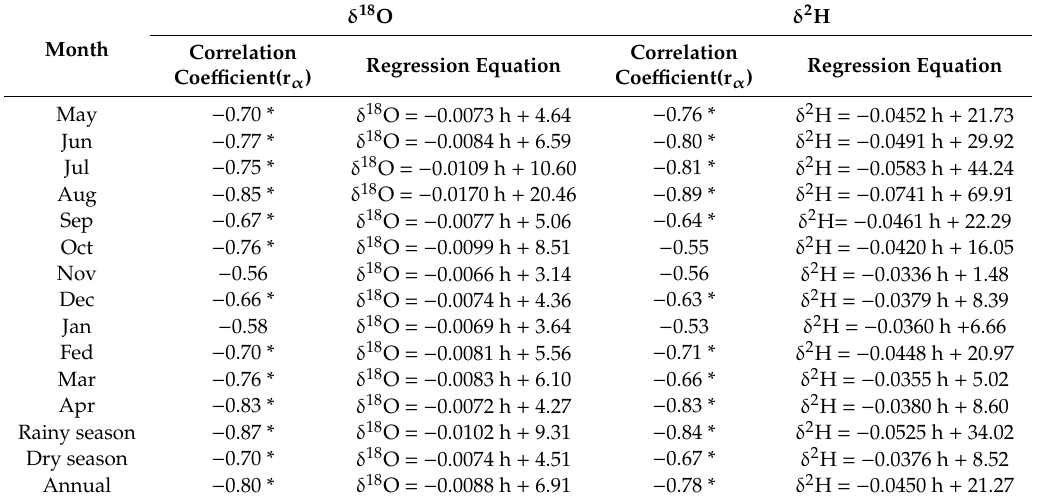
Table 1. The relationship between the stable isotope value of groundwater and the elevation in di ff erent months in the study